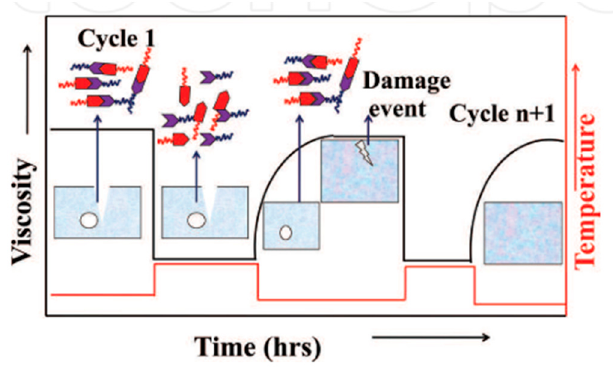
Figure 11. The concept of damage healing with the intrinsic approach. (Reprinted with permission from [75]. Copyright InTechopen’s, 2019).